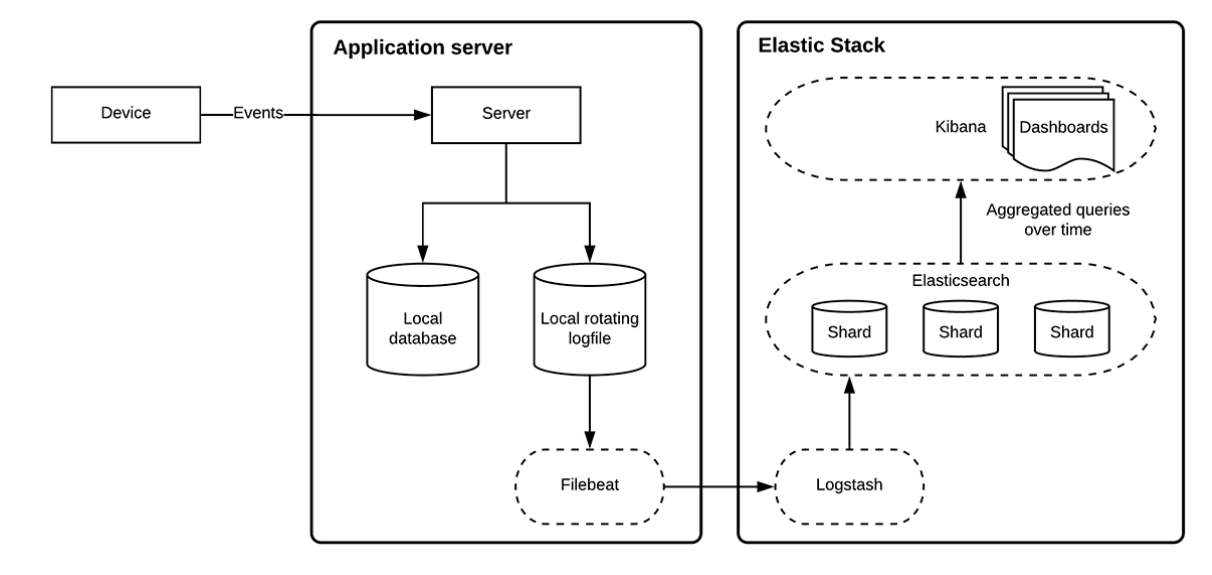
Figure 1. APEEE system architecture. APEEE: Analytics Platform to Evaluate Effective Engagement.